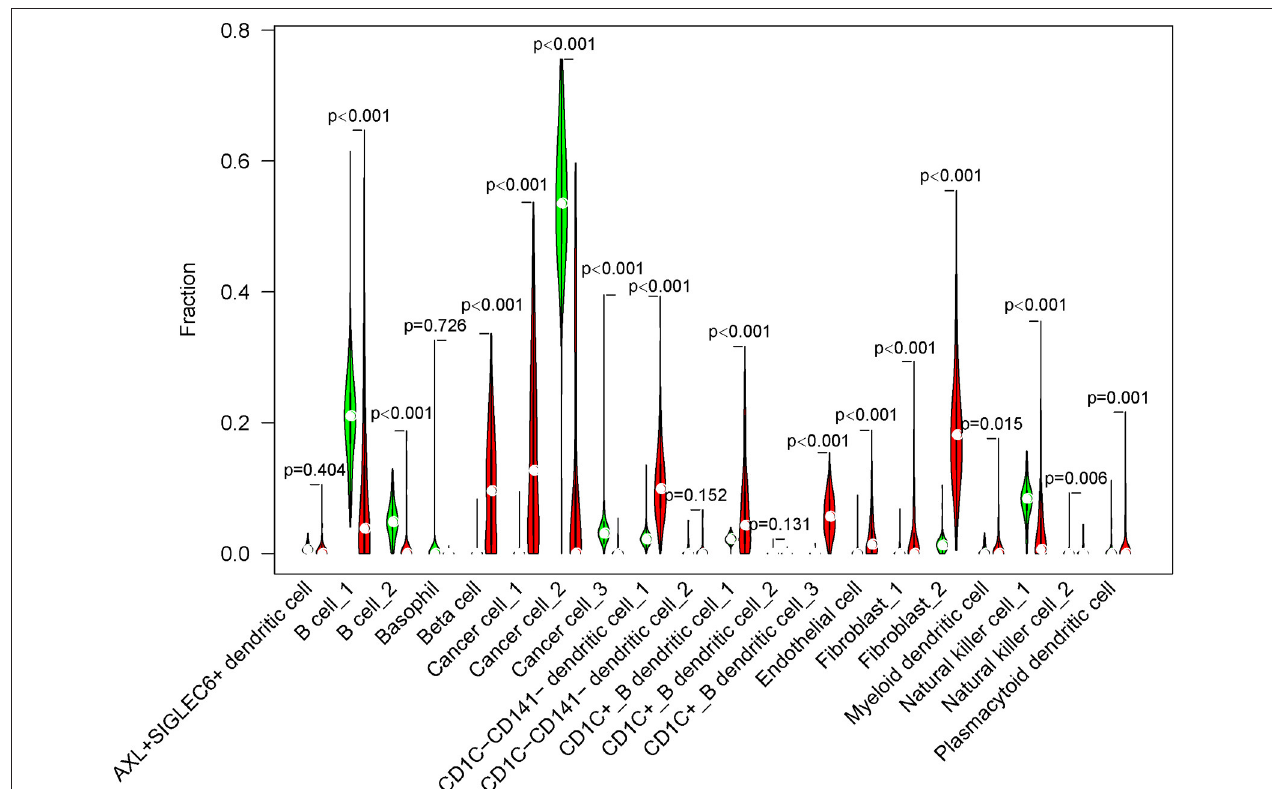
FIGURE 6 | The fraction of 20 cell subgroups in TCGA-PAAD dataset. Red indicates tumor samples and green indicates normal